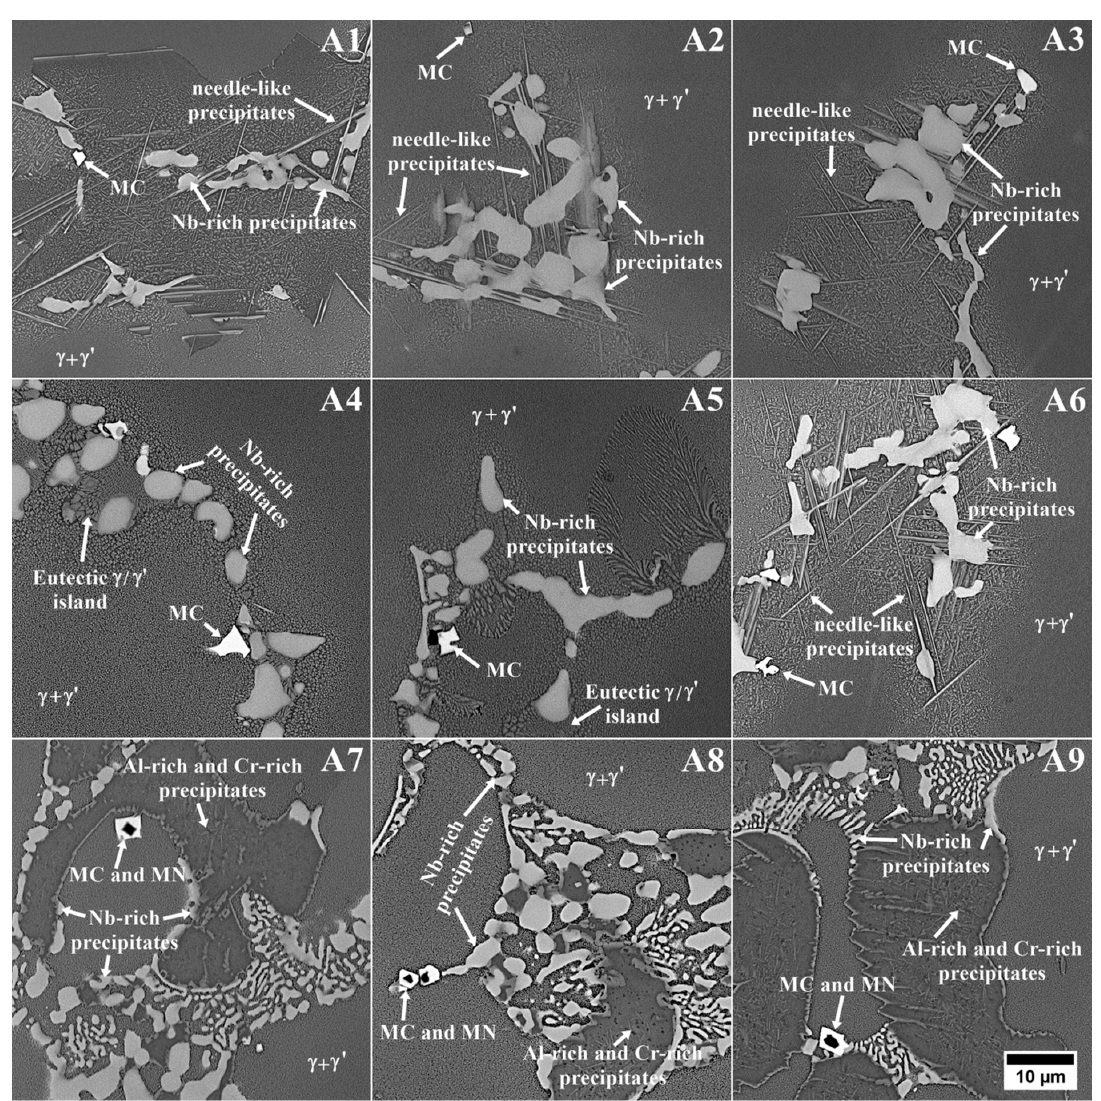
Figure 10. The microstructural constituents in the interdendritic spaces of modified Inconel 740 variants.